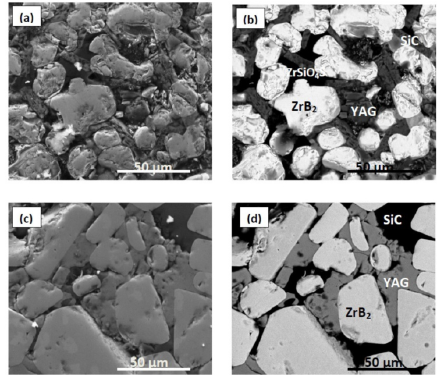
Fig. 4 SEM images after PLRS at 1680 ℃ : (a) 1.6 composite and (c) 2.0 composite, and corresponding BSE images: (b) 1.6 composite and (d) 2.0